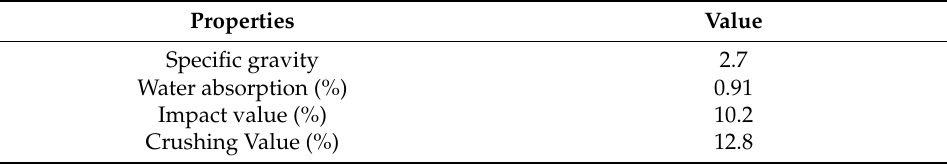
Table 2. Properties of coarse aggregate.